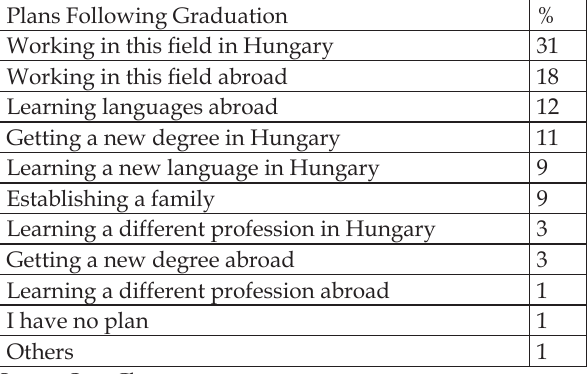
Table 1. Chart 1: Plans Following